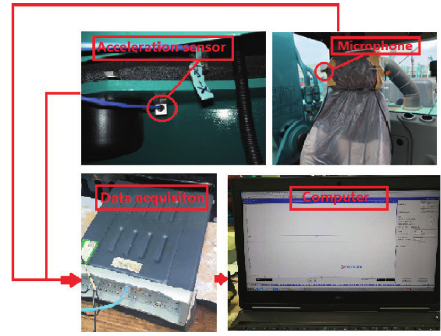
Figure 6: Baseline measurements for vibration and noise.